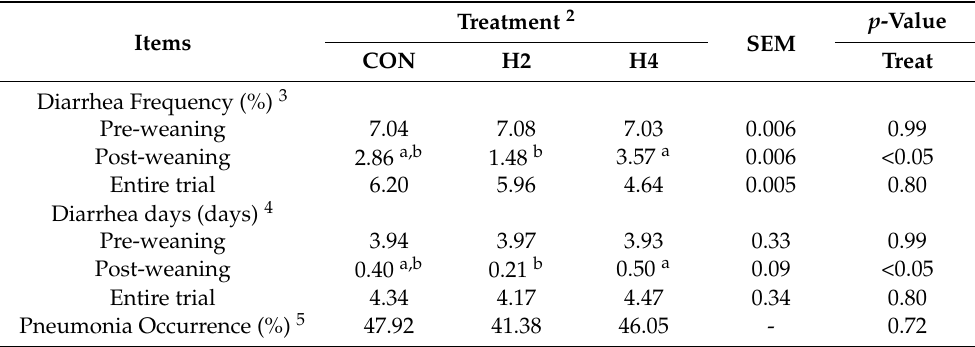
Table 7. Effects of hay supplementation at different ages on diarrheal frequency and rate in